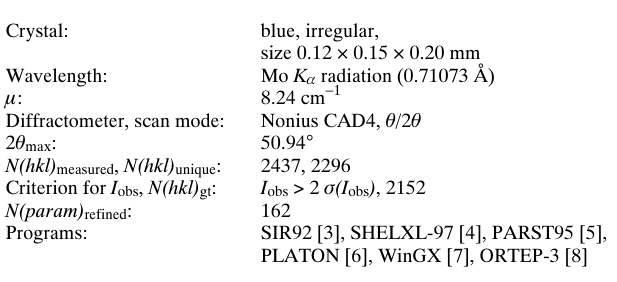
Table 1. Data collection and handling.